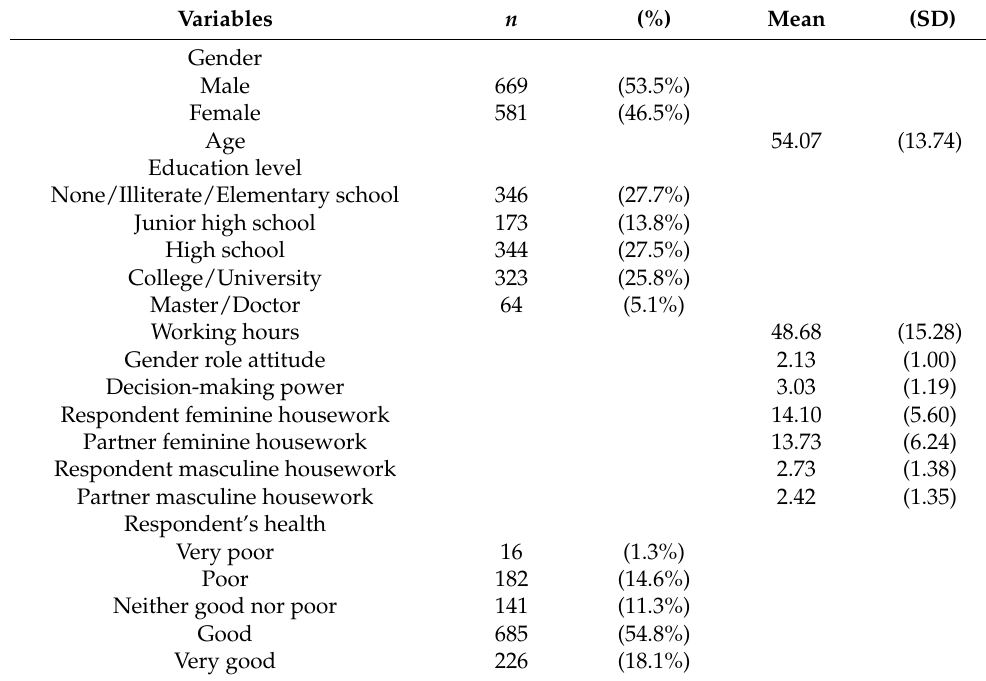
Table 1. Characteristics of the